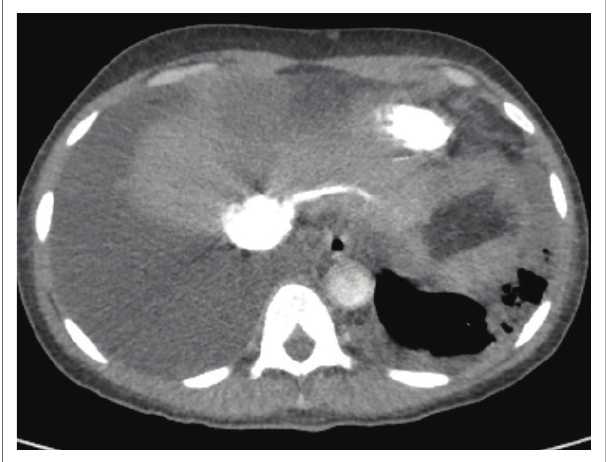
FIGURE 3 : Axial CT of a patient with a large right and smaller left pleural effusion.